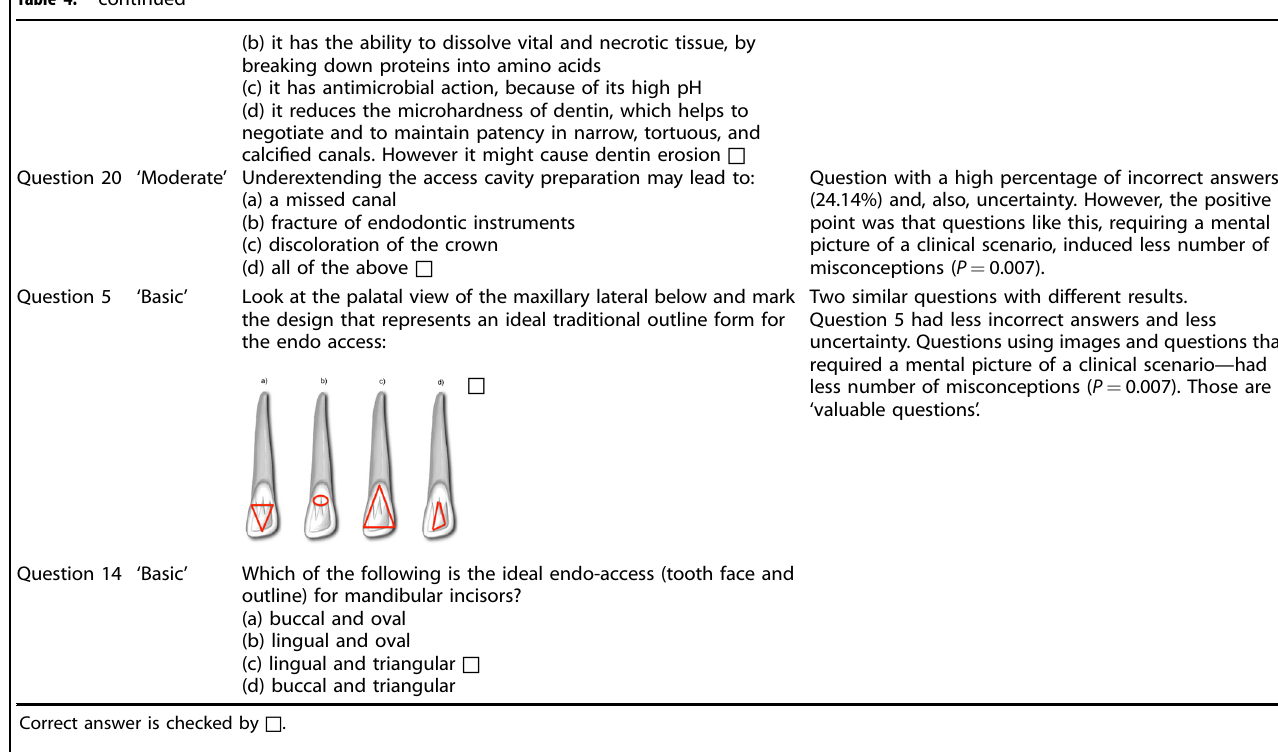
Table 5. Summary of statistical results considering the interaction between different variables.